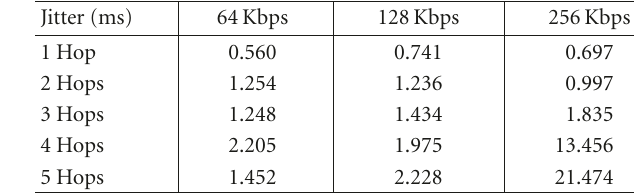
Table 3: Jitter: multicast routing and autoconfiguration.